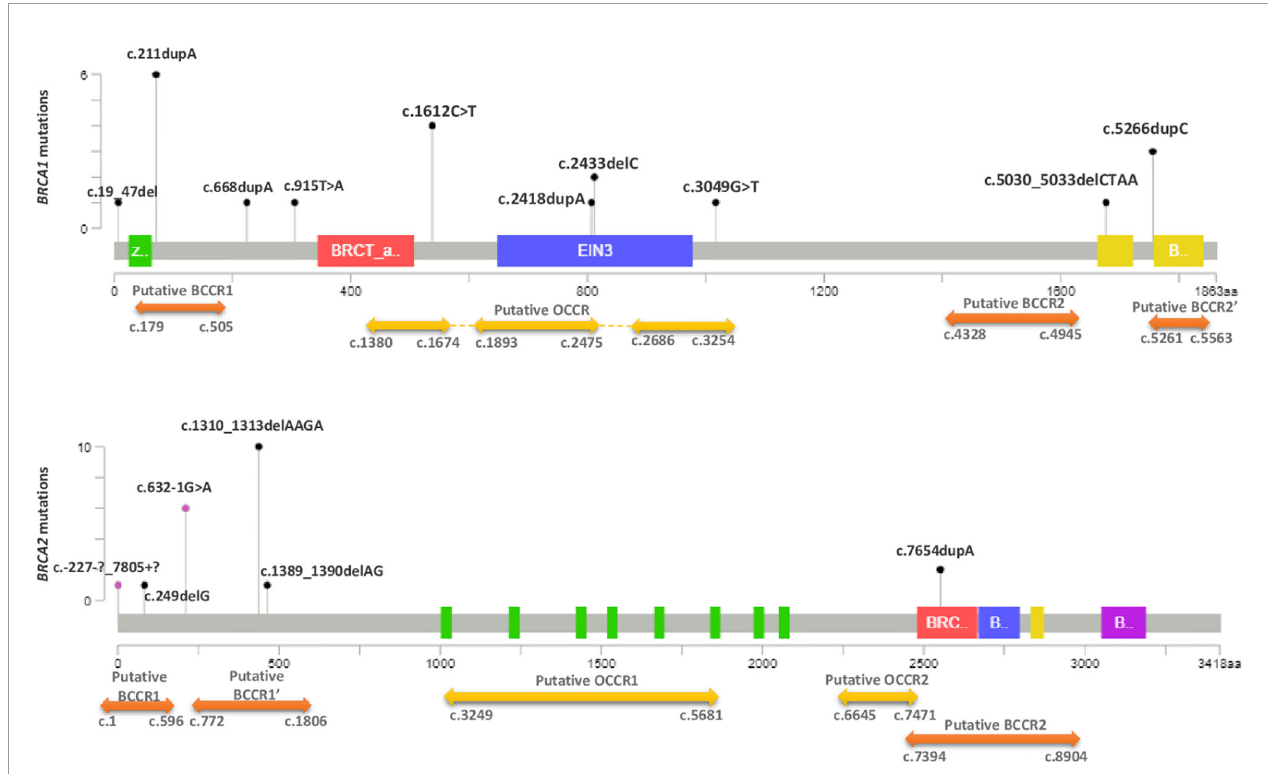
FIGURE 3 | Distribution of BRCA1 and BRCA2 mutations identi fi ed in hereditary breast and ovarian cancer cases. The Length of mutation indicator re fl ects the number of observed carriers. The diagrams linearly represent BRCA1/2 protein domains (x-axis). BRCA1 domains: Zinc/Ring fi nger (green); BRCT_assoc: serine-rich domain associated with BRCT (red); Ethylene insensitive 3 (blue); BRCA1 C terminus domain (yellow). BRCA2 domains: BRC repeats (green); BRCA-2_helical (red); oligonucleotide/oligosaccharide-binding, domain 1 (blue); tower domain (yellow) and oligonucleotide/oligosaccharide-binding, domain 3 (purple). Black mutation indicators depict truncating mutations and purple indicators represent the other types of mutations (splicing, LR). Cluster regions (breast cancer cluster regions (BCCRs) (orange) and ovarian cancer cluster regions (OCCRs) (yellow) were assigned according to the study of Rebbeck et al.